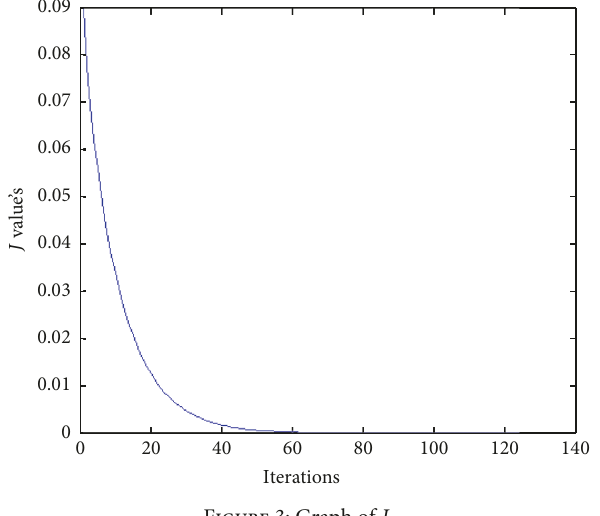
Figure 5: Initial temperature in err = 2% ‖𝜓 exact 0 ‖ 2 case. This figure shows that we can rebuild the true state.